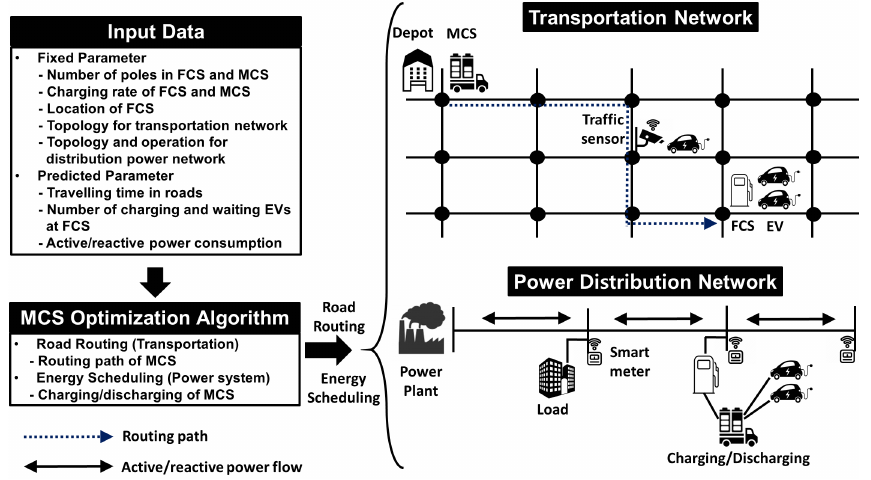
Figure 2. Conceptual system model for the proposed MCS control